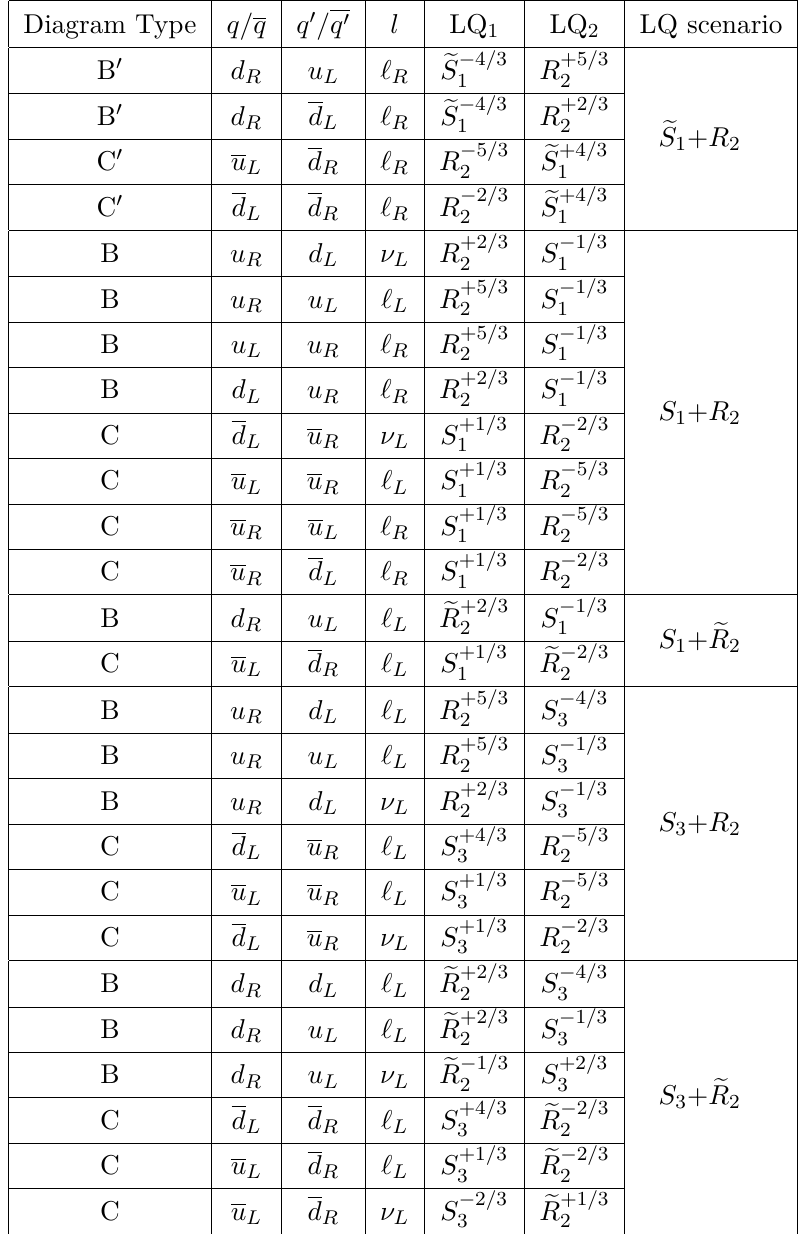
Table 3 . Asymmetric production with qq 0 and qq 0 initial states. See figure 2 for the diagram type.